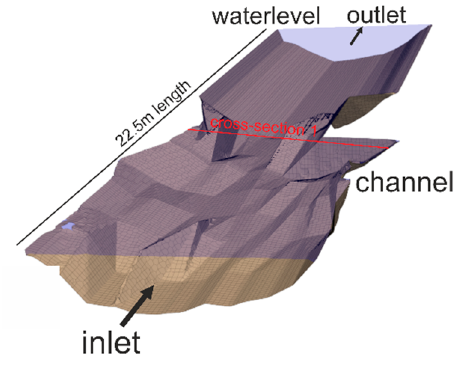
Figure 3. Geometry and boundaries used to simulate tracer dispersion.